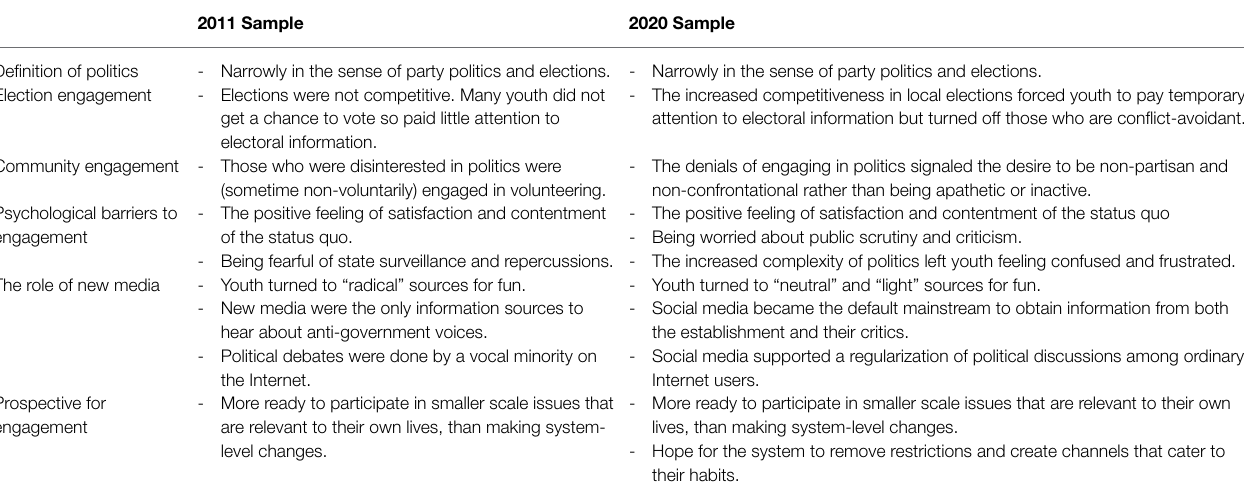
TABLE 2 | Summary of analyses of the 2011 and 2020